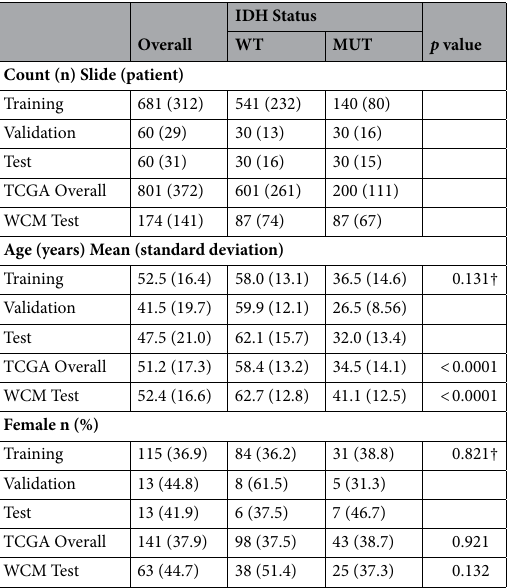
Table 1. Summary of the demographics for the TCGA training, validation, and test datasets and the WCM test datasets. No significant differences are seen in sex between the IDHmut and IDHwt groups. IDH mutant gliomas show statistically significant enrichment in younger patients, consistent with historic controls. † Average simulation p -value: 140 IDH WT slides in the training dataset were randomly sampled and one-way Anova was then conducted. Simulations were repeated 1000 times.